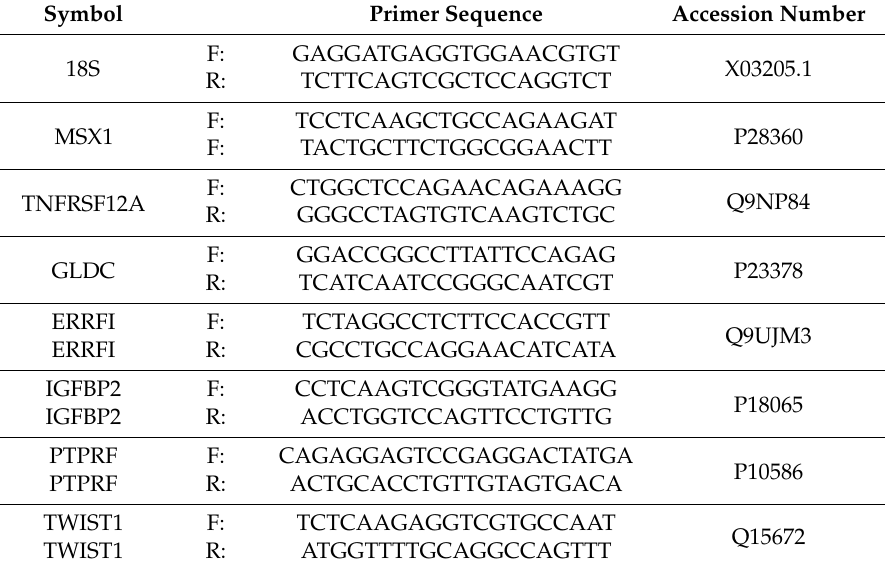
Table 5. Primers used for gene